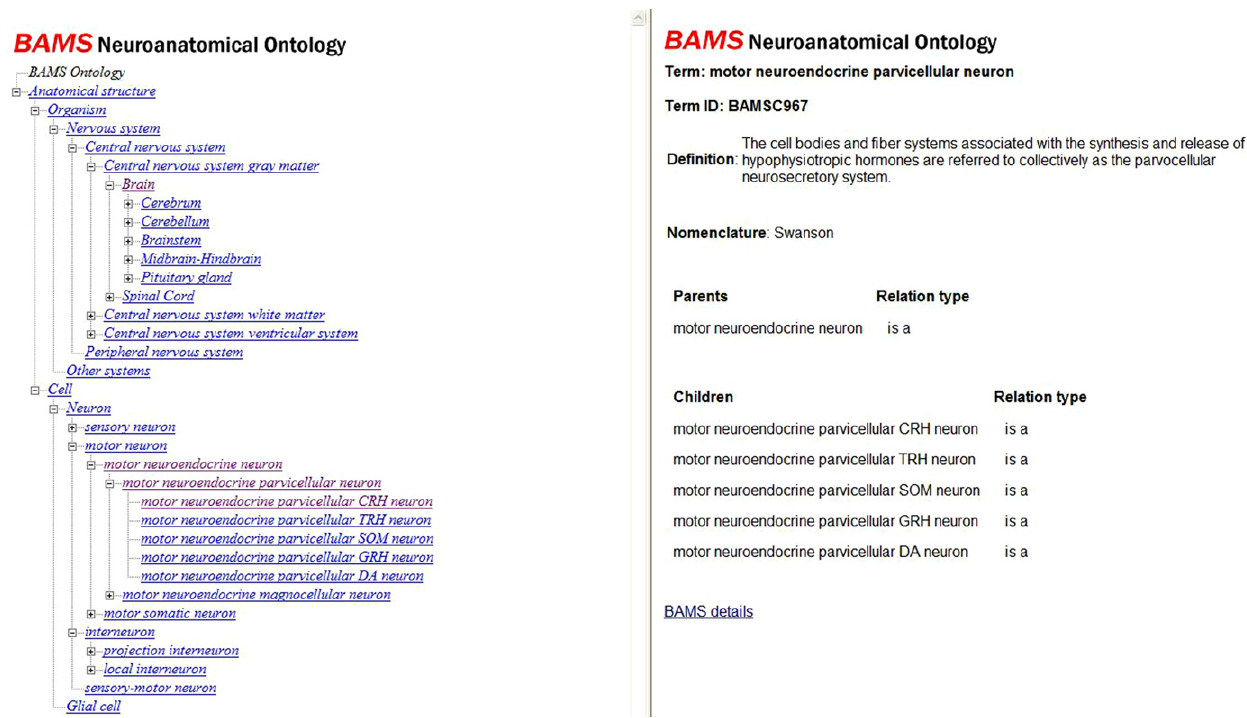
Figure 4. The web interface of BAMS Neuroanatomical Ontology allows users to browse concepts and retrieve their defi nitions, defi ning nomencla- tures, parents and children, and synonyms.